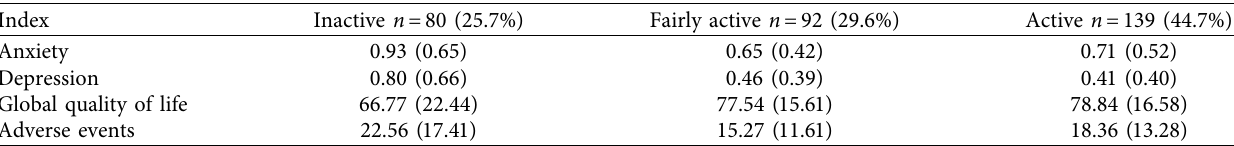
Table 3: Te means and standard deviations (in parenthesis) of psychological well-being and quality of life indices across participants’ level of exercise at month twelve ( n � 311). Only the indices with a statistically signifcant diference across the various levels of exercise are included in the